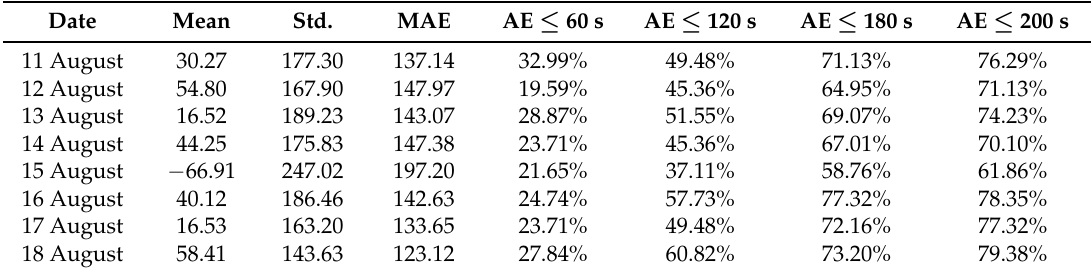
Table 3. Queuing time estimation errors from 11 August to 18 August.